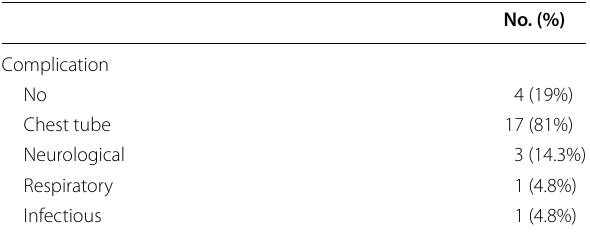
Table 4 Distribution of the studied cases according